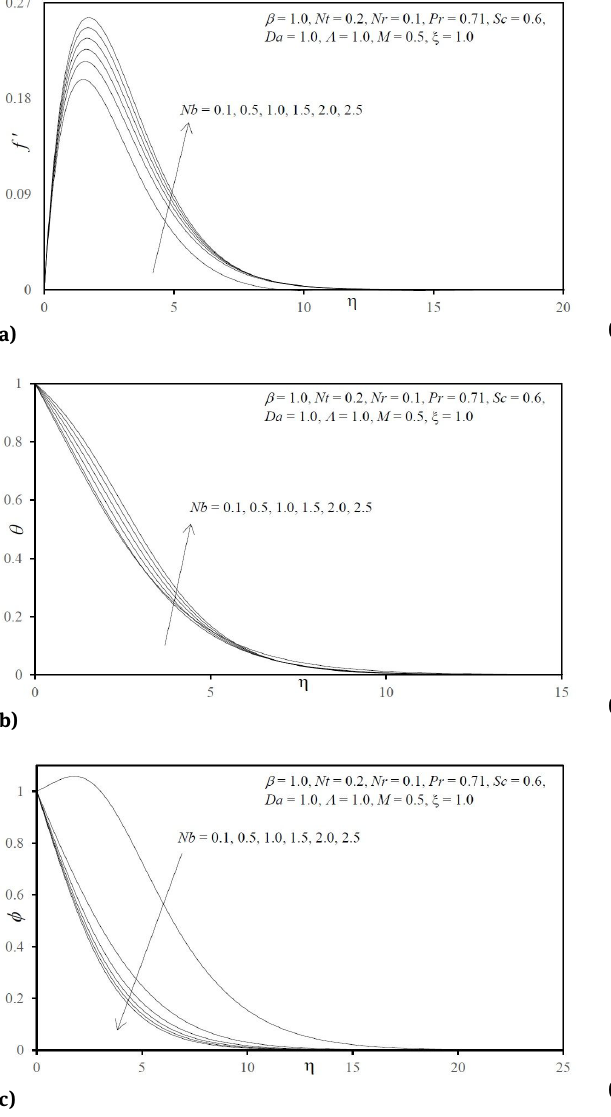
Fig. 5: (a) Influence of Nt on Velocity Profiles; (b) Influence of Nt on Temperature Profiles; (c) Influence of Nt on Concentration